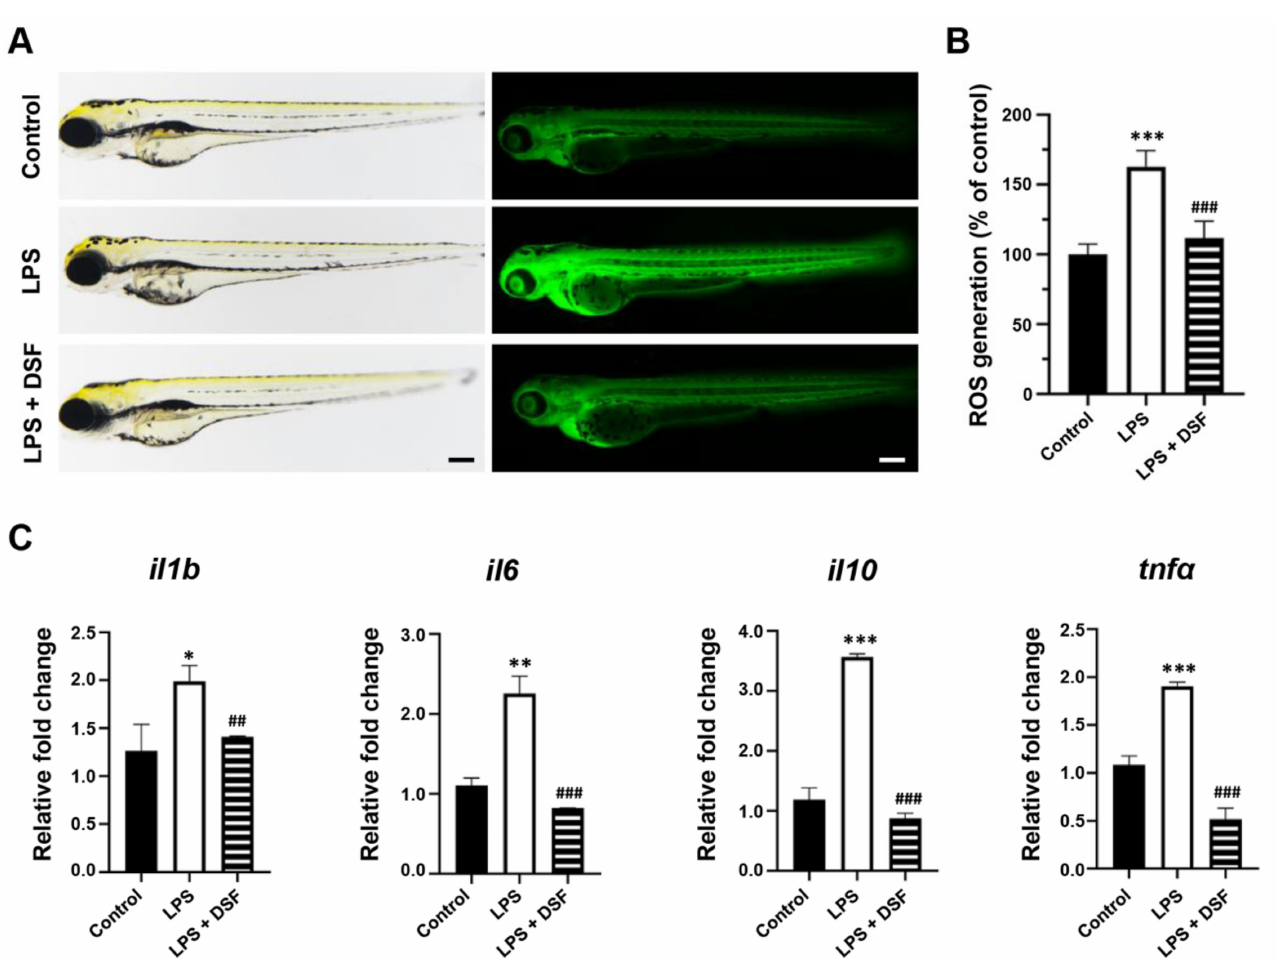
Figure 4. DSF inhibited LPS-induced ROS production and inflammation in zebrafish embryos. ( A ) ROS generation in zebrafish embryos was detected with fluorescent probe DCFH-DA staining. ( B ) ROS levels were measured by quantification of fluorescence intensity for individual embryos using fluorescence microscopy and ImageJ analysis. ( C ) The relative mRNA expression levels of inflammatory markers ( il1b , il6 , il10 , and tnf α ) were measured with qRT-PCR. Data are represented as mean ± S.D. * p < 0.05, ** p < 0.01, *** p < 0.001 vs. control group; ## p < 0.01, and ### p < 0.001 vs. LPS group. Scale bar, 200 µ